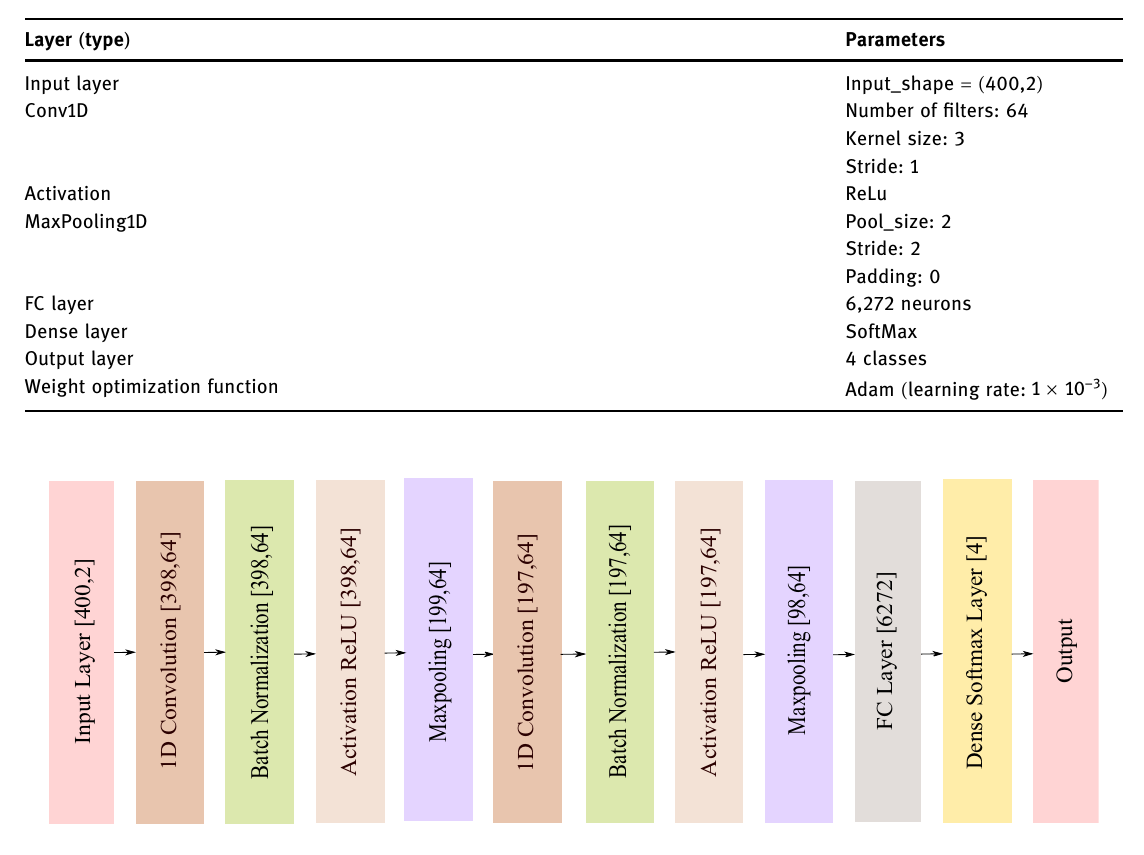
Correct predictions Total predictions